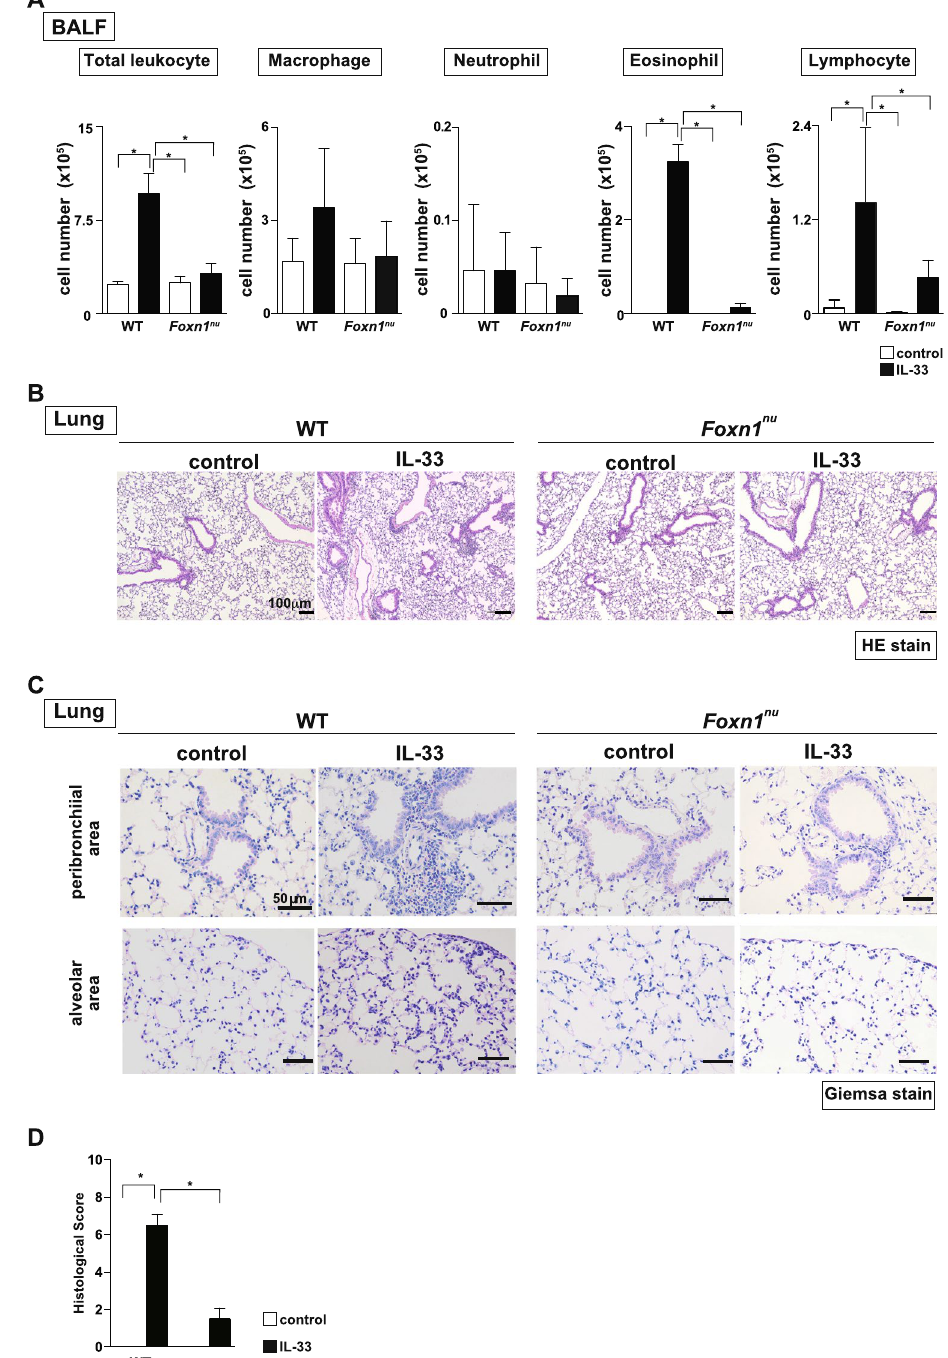
Figure 3. Foxn1 nu mice showed attenuated eosinophilic inflammation induced by the administration of IL- 33. IL-33 or saline (control) was administered intratracheally to BALB/c mice (wild type) or Foxn1 nu mice on Day 0, and the indicated assays were performed on Day 14. ( A ) Absolute cell numbers of total leukocytes, macrophages, neutrophils, eosinophils, and lymphocytes in the BAL fluid are shown. The mean values ± SD are shown for four mice per group. ( B,C) Representative histology of the lungs from mice as in A , fixed and stained with hematoxylin and eosin reagent ( B) or Giemsa reagent ( C) . Scale bars: 100 μ m in ( B) , 50 μ m in ( C) . ( D ) Histological scores from Giemsa-stained samples are depicted. Three independent experiments were performed, and similar results were obtained. * p < 0.05: one-way